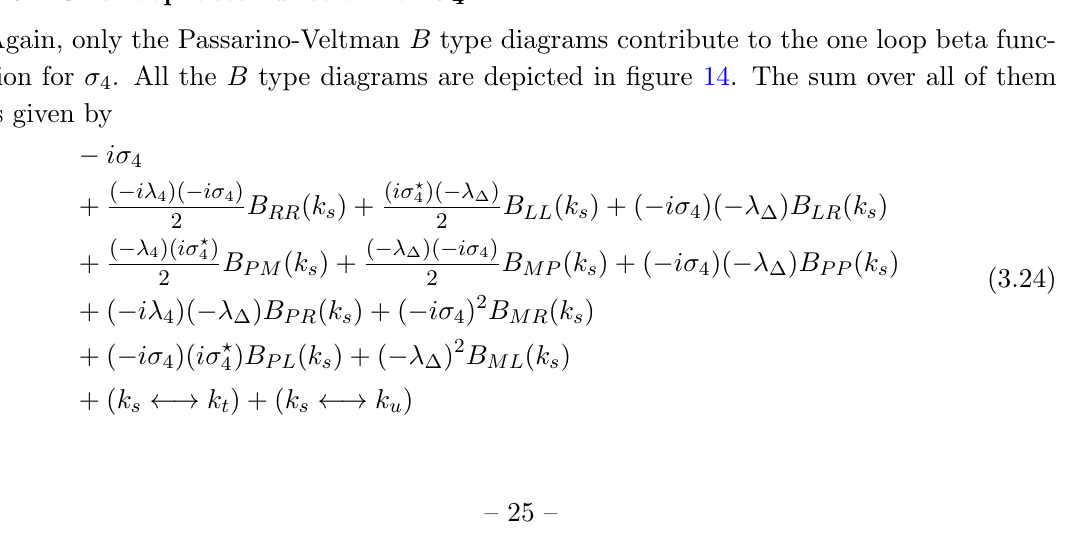
(cid:30) R (cid:30) L !